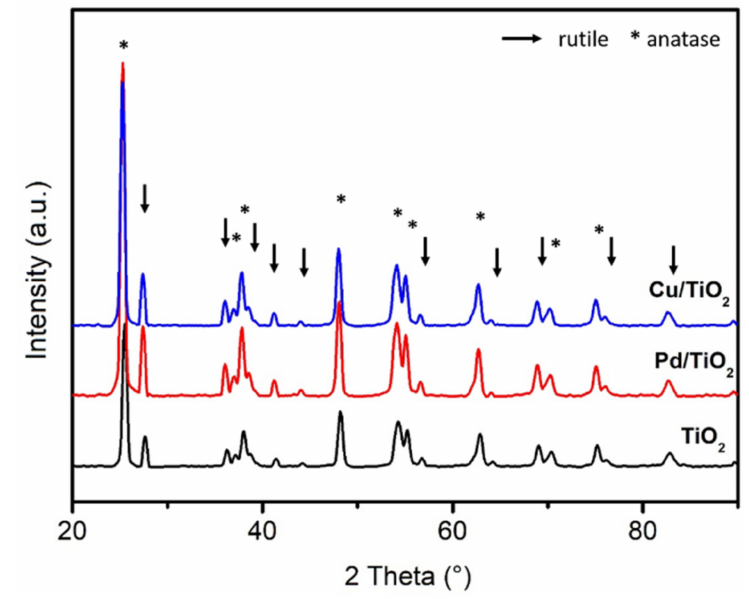
Figure 1. The XRD patterns of the